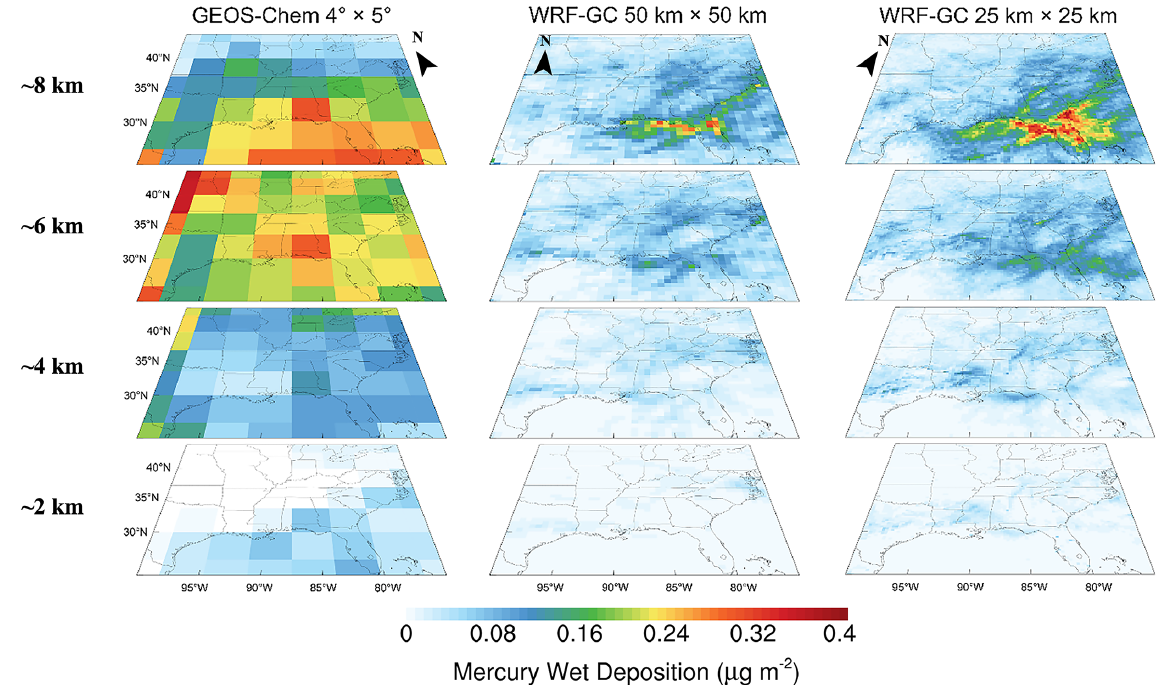
Figure 10. Comparison of LS of GEOS-Chem and WRF-GC at different levels and resolutions. From top to bottom: Hg wet deposition at ∼ 2, ∼ 4, ∼ 6, and ∼ 8km, respectively. The first column is GEOS-Chem 4 ◦ × 5 ◦ simulation results. Other columns from left to right correspond to different WRF-GC resolutions: 50km × 50km and 25km ×